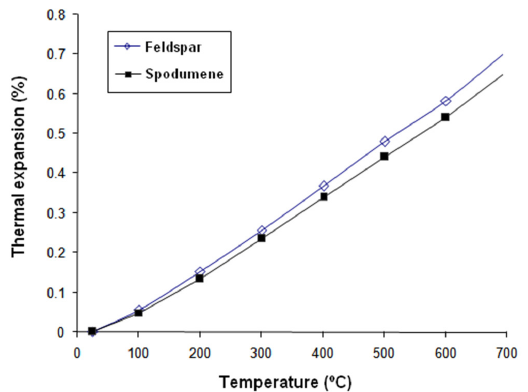
Figure 3. Linear thermal